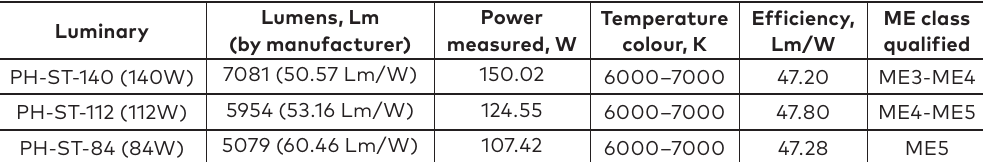
Table 3. The main parameters of photon-L LED luminary tested in LAB and Riga PilotSite in